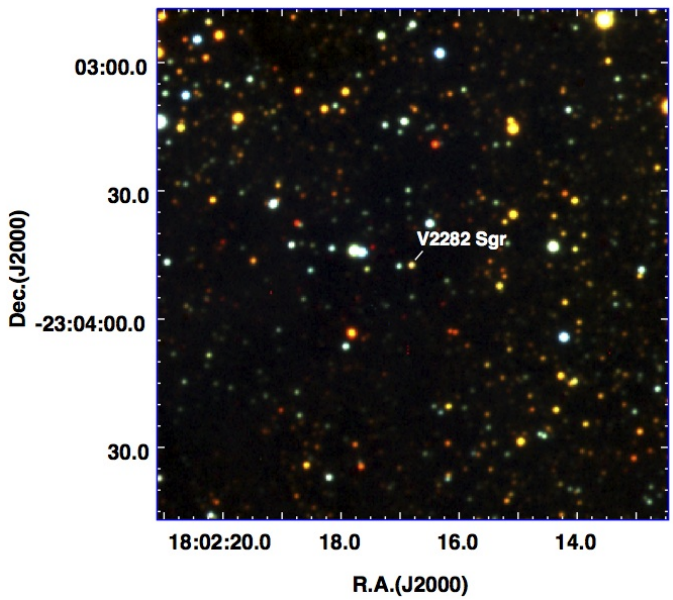
Fig. 4. Color composite of V2282 Sgr from the UKIDSS images in J , H and K s passbands. The fainter star to the left from the variable, quoted in the text, is not resolved in the 2MASS